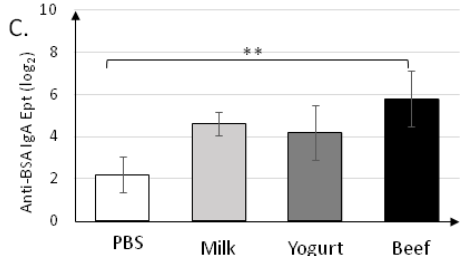
Figure 4. Levels of secretory IgA specific to anti-α-CN ( A ), anti-β-lg ( B ), and anti-BSA ( C ) in fecal samples collected on day 30 of the experiment. Data are the mean ( n = 10) ± SD. * p < 0.05, ** p < 0.01, *** p < 0.001, Kruskal–Wallis test and one-way ANOVA with Tukey post-hoc tests.